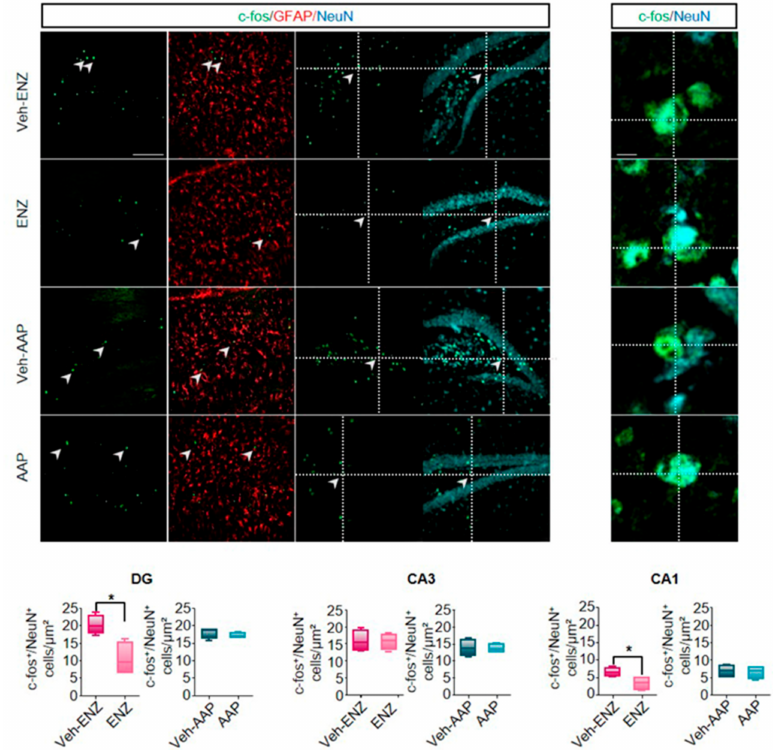
Figure 8. ENZ treatment impairs neuronal activity in dorsal hippocampus. Note. Representative immunolabeling and quantification of c-fos (green) expression in NeuN+—(red) or GFAP+—(cyan) cells. Intersecting lines evidenced co-localization of NeuN+—cells expressing c-fos. Whisker box plots quantification of the number of c-fos+/NeuN+—cells in the DG, CA3 and CA1 areas of dHP of ENZ- and AAP-treated mice compared with respective vehicles. Statistical quantifications were performed using Mann–Whitney test. Bars are mean ± SEM ( n = 4 mice), * p < 0.05. Scale bars: 100 µ m. AAP, abiraterone acetate-prednisone; CA1, cornus ammonis 1; CA3, cornus ammonis 3;